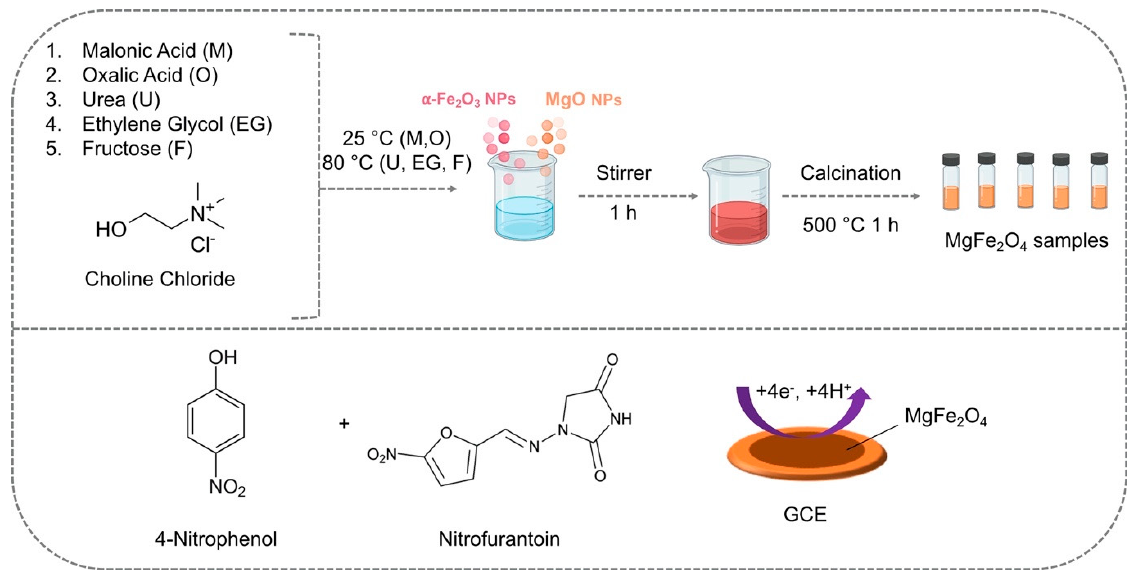
Figure 4. Synthetic path of various DES-assisted MgFe 2 O 4 and their use in the electrochemical detection of 4-NP and NFT. Reprinted (adapted) with permission from Baby, J.N.; Sriram, B.; Wang, S.-F.; George, M. Effect of Various Deep Eutectic Solvents on the Sustainable Synthesis of MgFe 2 O 4 Nanoparticles for Simultaneous Electrochemical Determination of Nitrofurantoin and 4-Nitrophenol. ACS Sustain. Chem. Eng. 2020 , 8 , 1479–1486. Copyright 2020, American Chemical Society